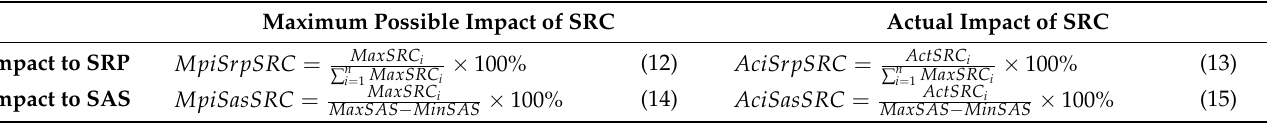
Table 5. Security requirement impact metrics (for SRC).